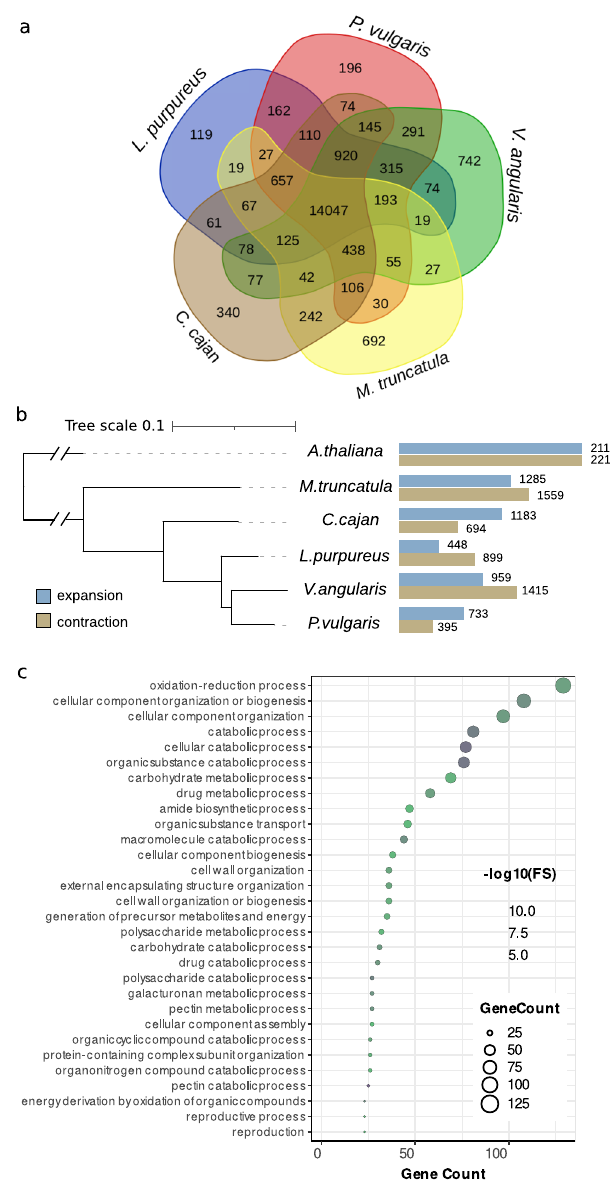
Fig. 2 | Gene families in lablab. a Venn diagram of the number of gene families common among and unique to lablab , Phaseolus vulgaris, Vigna angularis, Medi- cago truncatula , and Cajanus cajan . b Cladogram of the analysed species showing the number of expanded and contracted gene families in each. Figure constructed with iTol 93 . c Gene ontology terms enriched in the set of expanded gene familiesin Lablab purpureus . Source data are provided as a Source Data fi